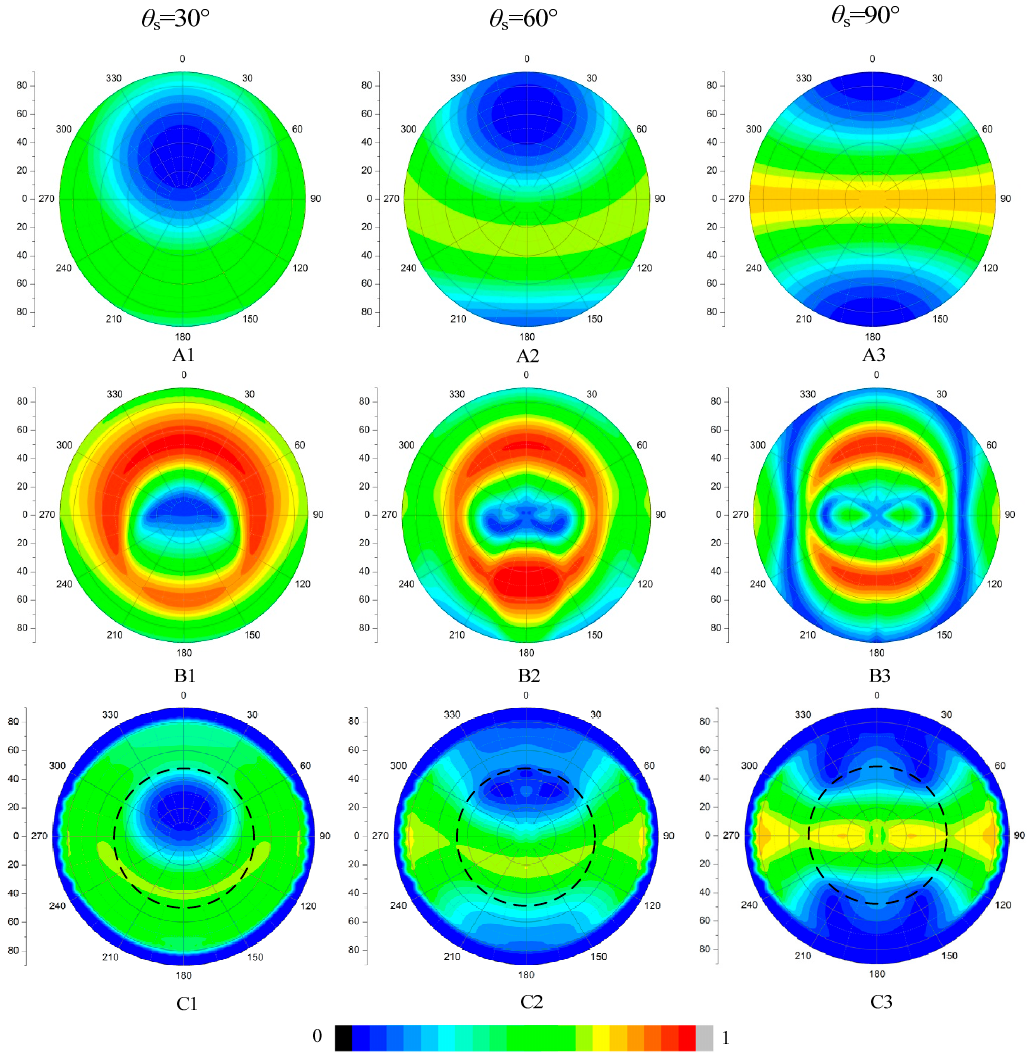
Figure 12. The DOP patterns of the: skylight ( A ); reflected light ( B ); and refracted light ( C ) under different SZAs (30°, 60° and 90°), where the wind speed is 5 m/s, and wind direction is 0°.